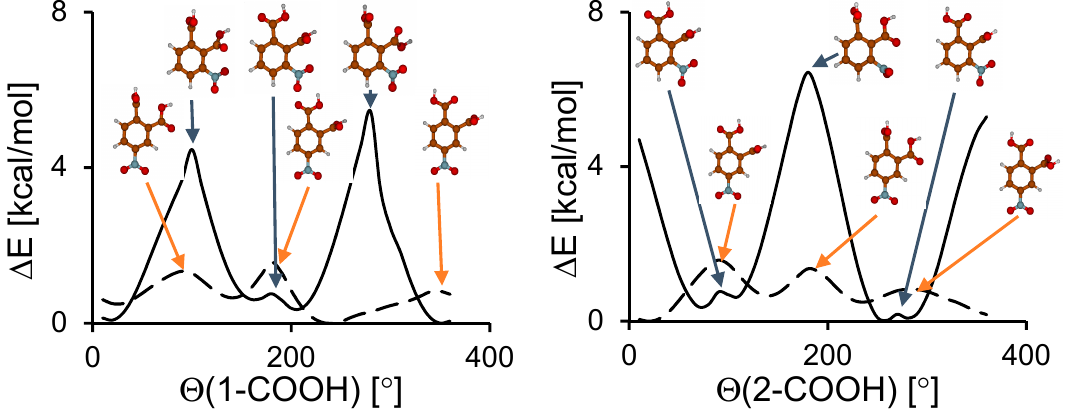
Figure 3. Calculated potential energy curves for the carboxyl group rotation in 3 (solid line) and 4 (dashed line).